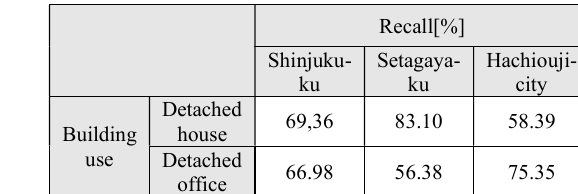
Table 7 . Accuracy for each municipality